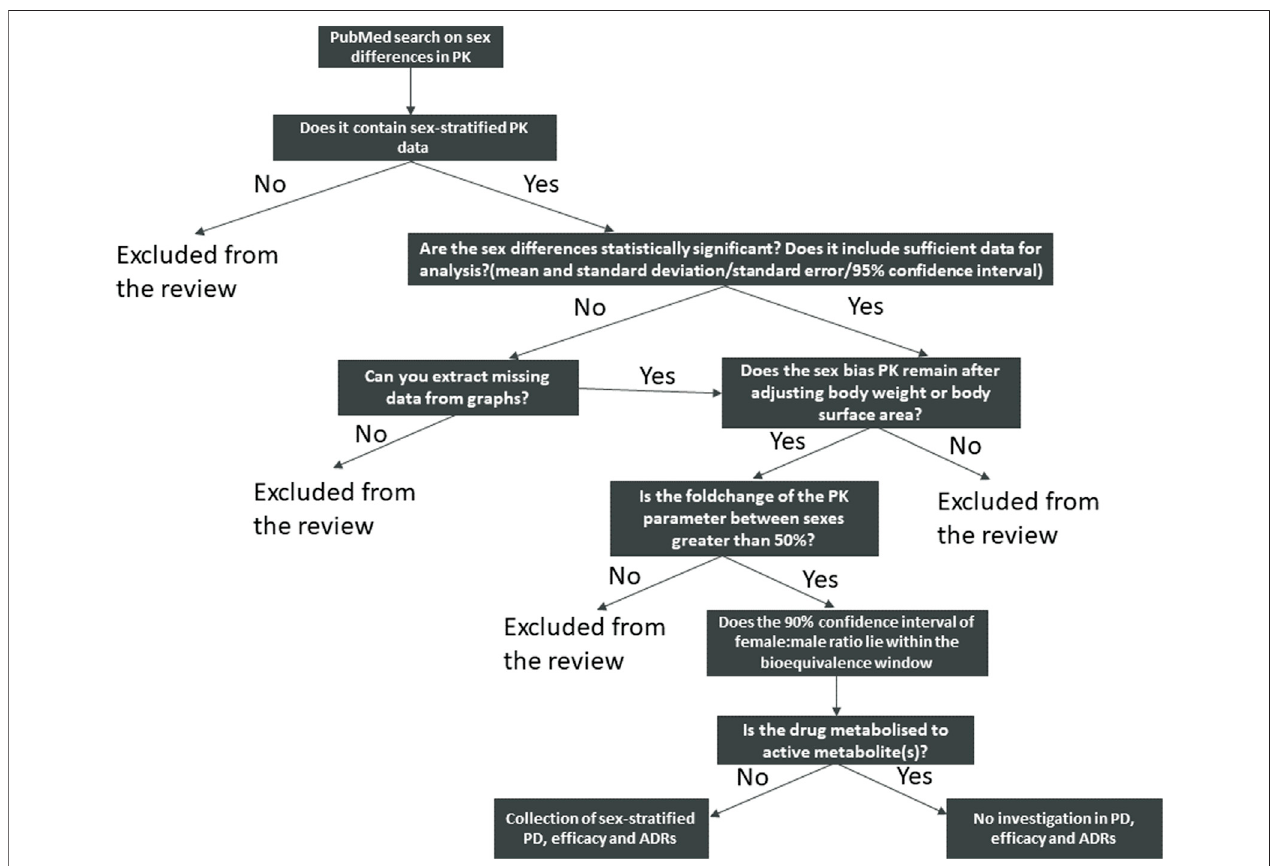
FIGURE 1 | Schematic view of the search strategy and identi fi cation of the drugs included in this review.